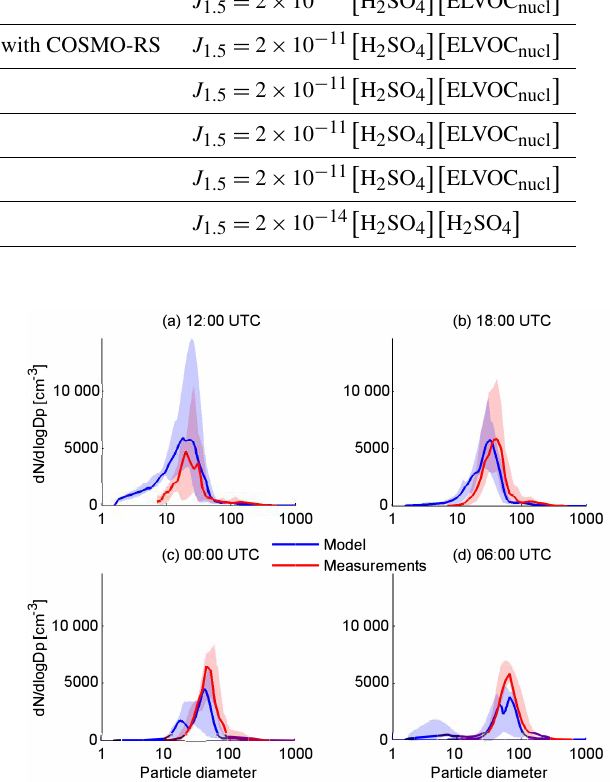
Figure 2. (a) Modeled and (b) measured number size distribution at Pallas, 5 July 2006.